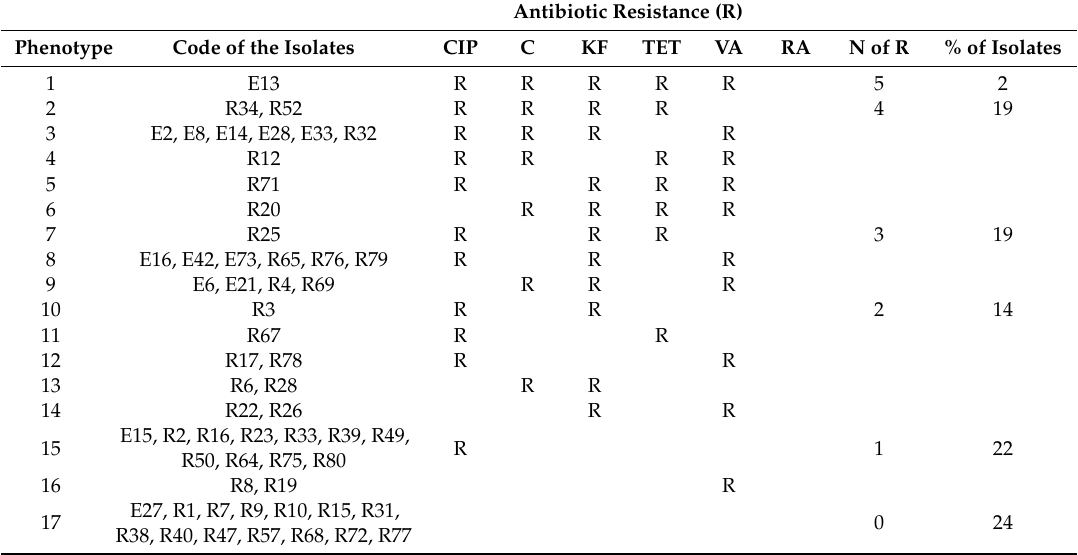
Table 2. Antibiotic-resistance phenotypes. The code of the isolates is simplified and includes only the fractionoforigin(R = rhizosphere; E = endosphere)andtheprogressivenumber. Thepercentageinthelast column is referred to the strains belonging to each phenotype. CIP = ciprofloxacin; C = chloramphenicol; KF = cephalotin; TET = tetracycline; VA = vancomycin; RA = rifampicin. ‘R’: refers to the strain resistance to the antibiotic at the indicated